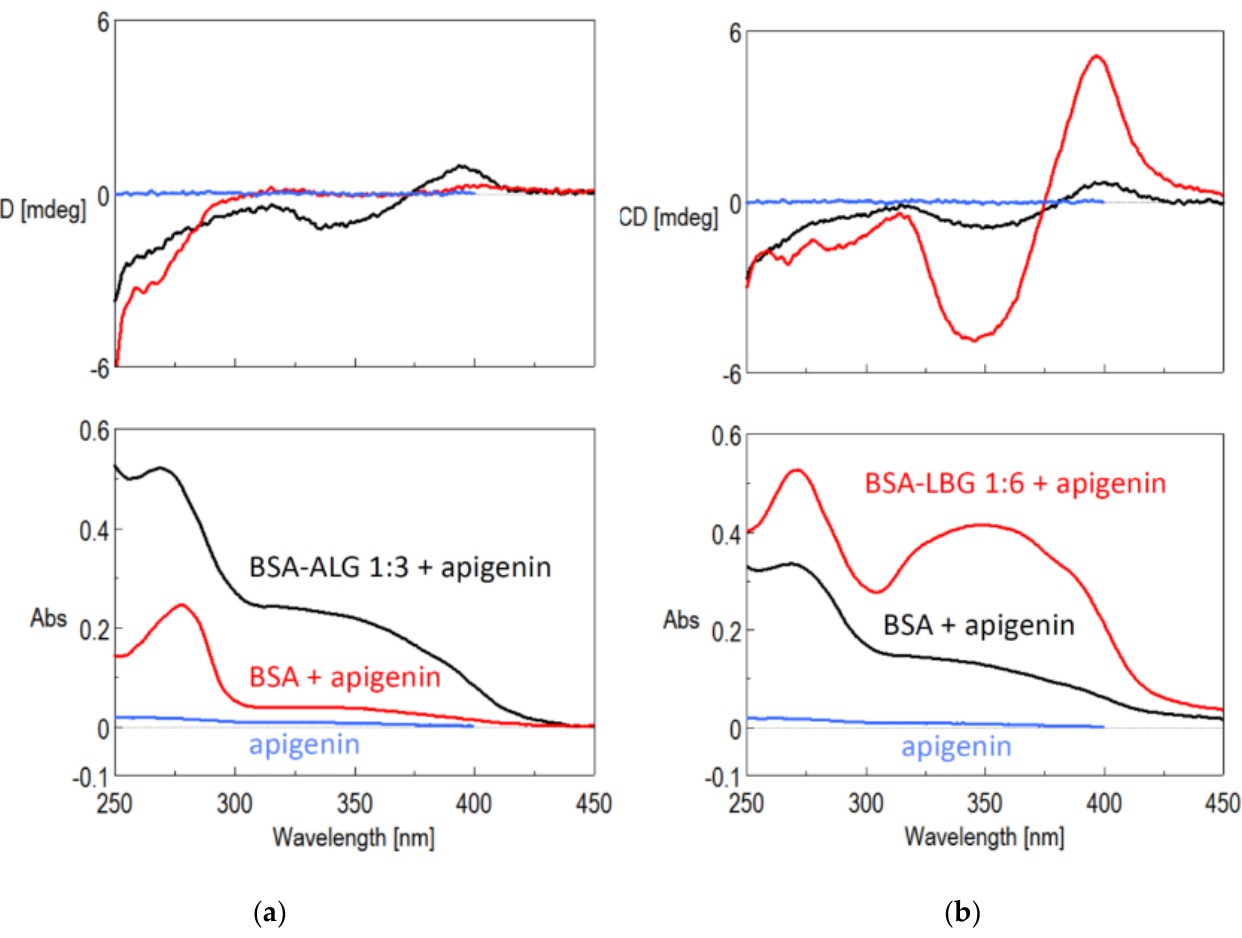
Figure 9. ( a ) ICD (upper) and UV (bottom) spectra of aqueous solution of apigenin (blue), the BSA–apigenin complex (black), and the BSA–ALG 1:3–apigenin complex (red); ( b ) ICD (upper) and UV spectra (lower) of aqueous solution of apigenin (blue), the BSA–apigenin complex (red) and the BSA–LBG 1:6–apigenin complex (black).